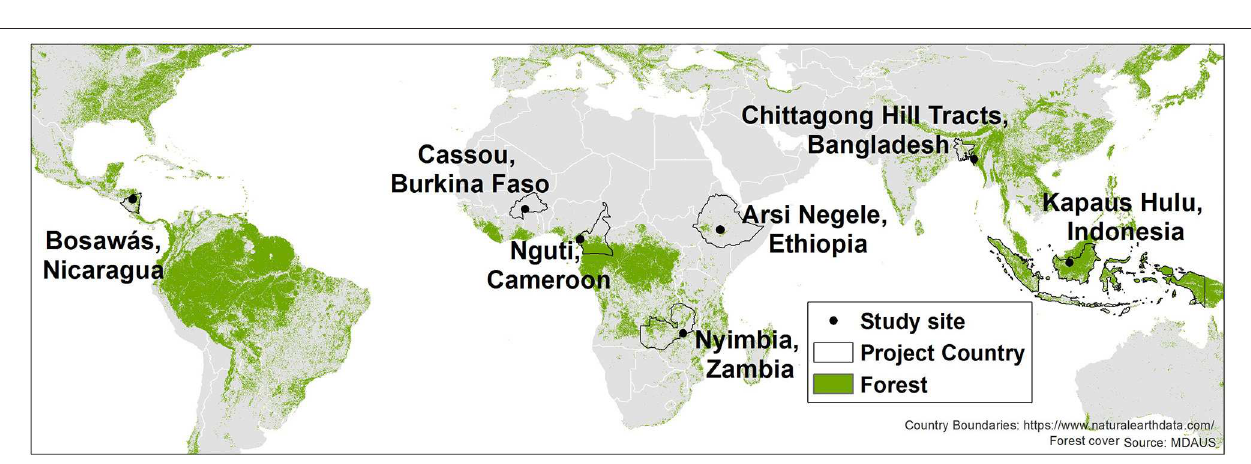
FIGURE 2 | Location of the seven study landscapes. For the global context, forest cover shown here is derived from the commercially available MDA US dataset produced from Landsat 8. However, for our analysis, we conducted site-specific forest cover mapping to ensure locally accurate results.